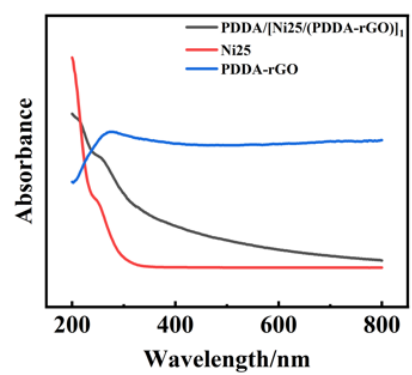
Figure 3. UV − vis spectra of Ni25 solution (red curve), PDDA − rGO suspension (blue curve) and the composite film PDDA/[Ni25/(PDDA − rGO)] 1 (black curve).